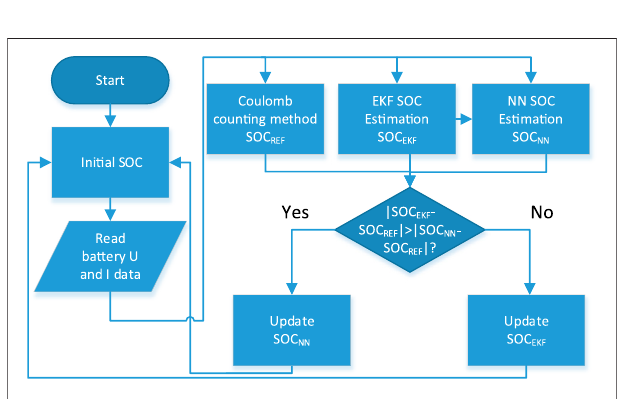
FIGURE 7 | The fl owchart of integration NN and EKF.